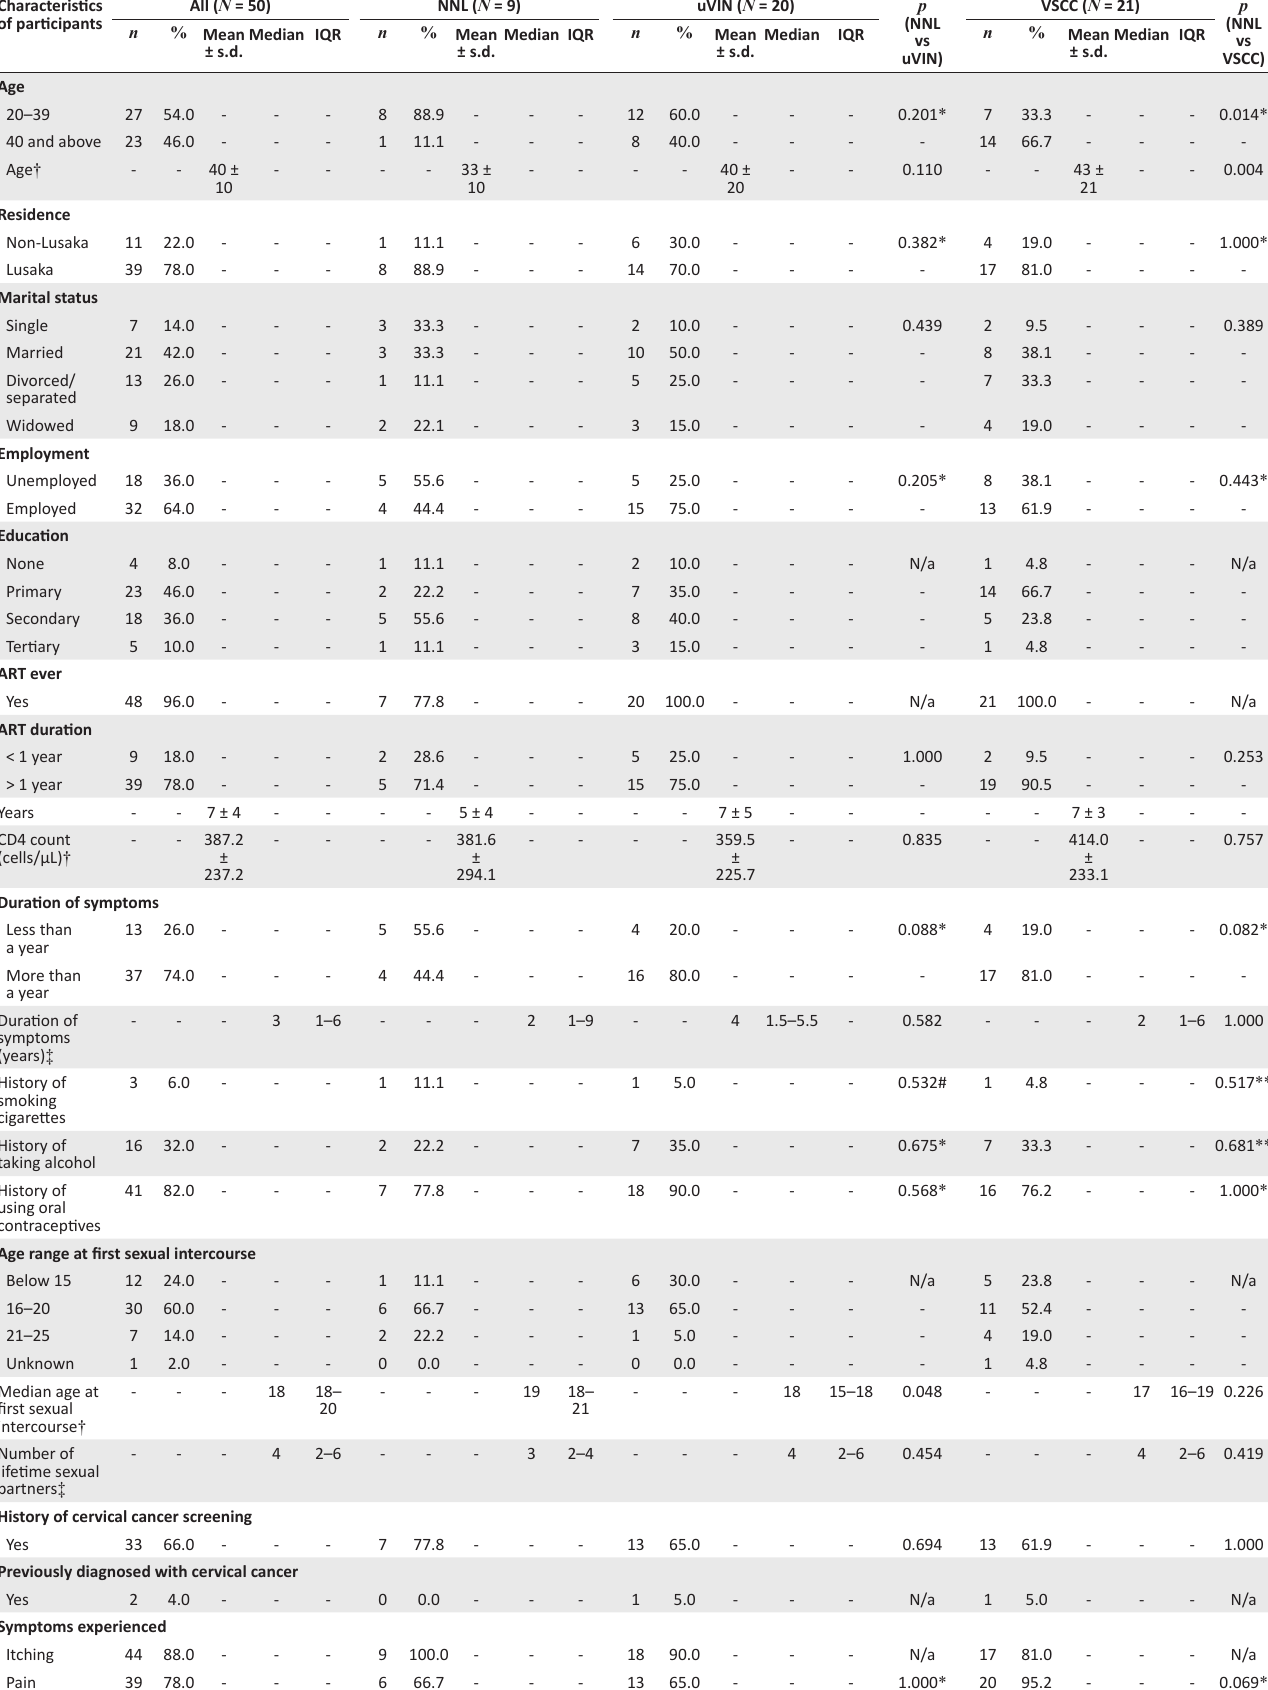
TABLE 1: Characteristics of participants diagnosed with usual uVIN, VSCC and NNL at the University Teaching Hospital’s gynaecologic clinic, Zambia, 2018. Characteristics of